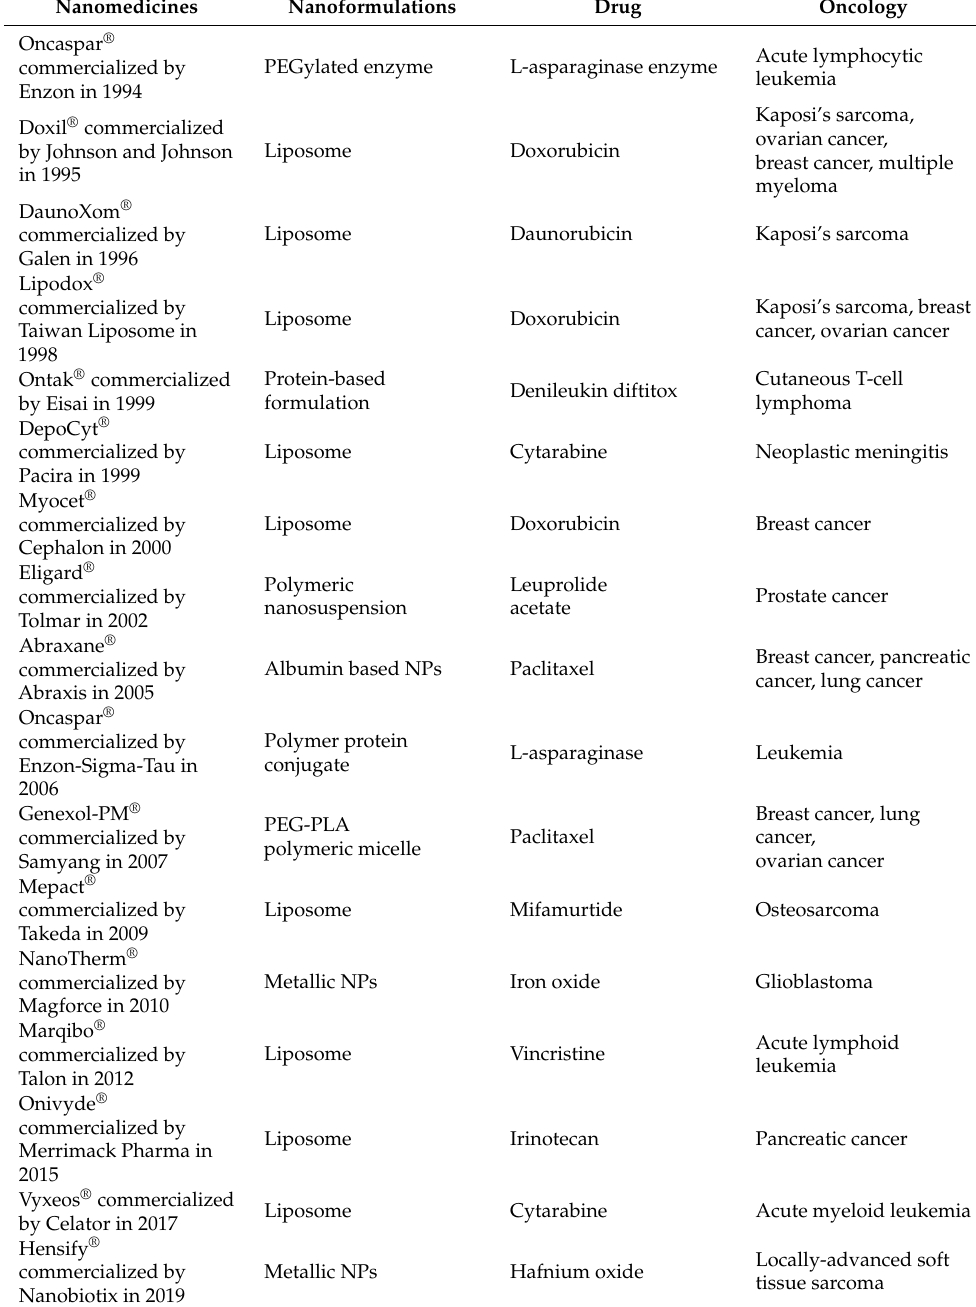
Table 1. Nanomedicines available in the market for cancer